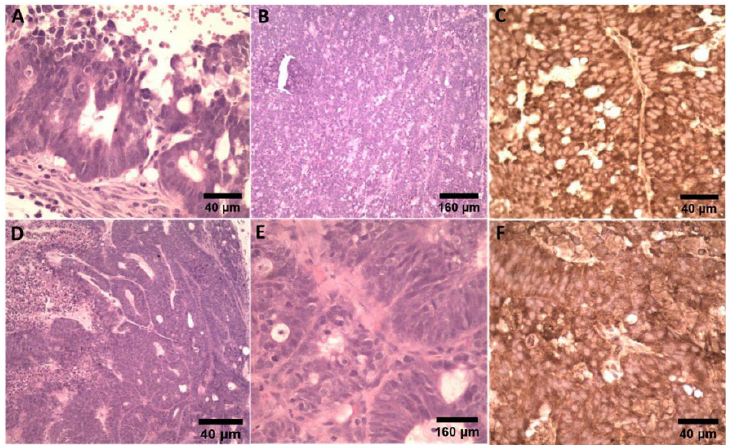
Figure 5. Micrographs of hematoxylin and eosin (H&E), HER2, and PTK7 IHC staining of harvested LS174T tumor tissue. LS174T tumors were PTK7-positive and HER2-negative. ( A – C ) Tumor #1 showed minimal incomplete membrane expression for HER2 (score 1+) and diffuse cytoplasmic positivity for PTK7. ( D – F ) For tumor #2, HER2 expression was not observed (score 0) and diffuse cytoplasmic positivity for PTK7.